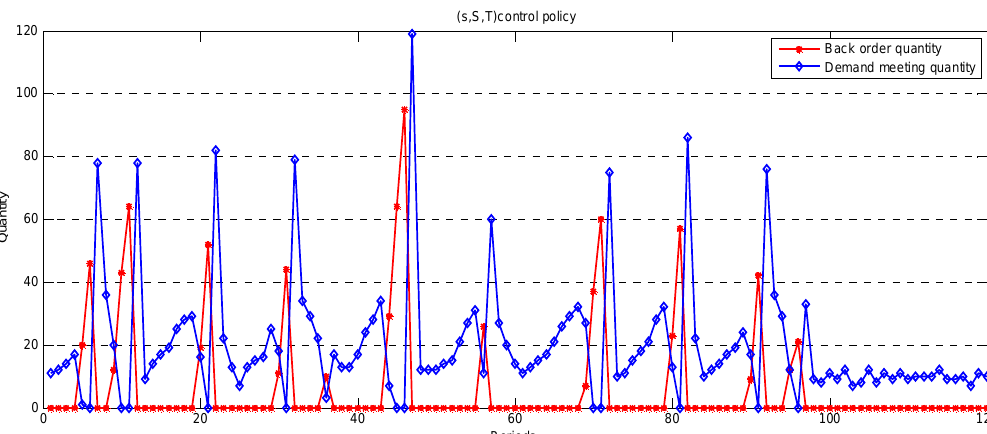
Fig.13. Back order and Demand meeting curve of adaptive (s,S,T) control